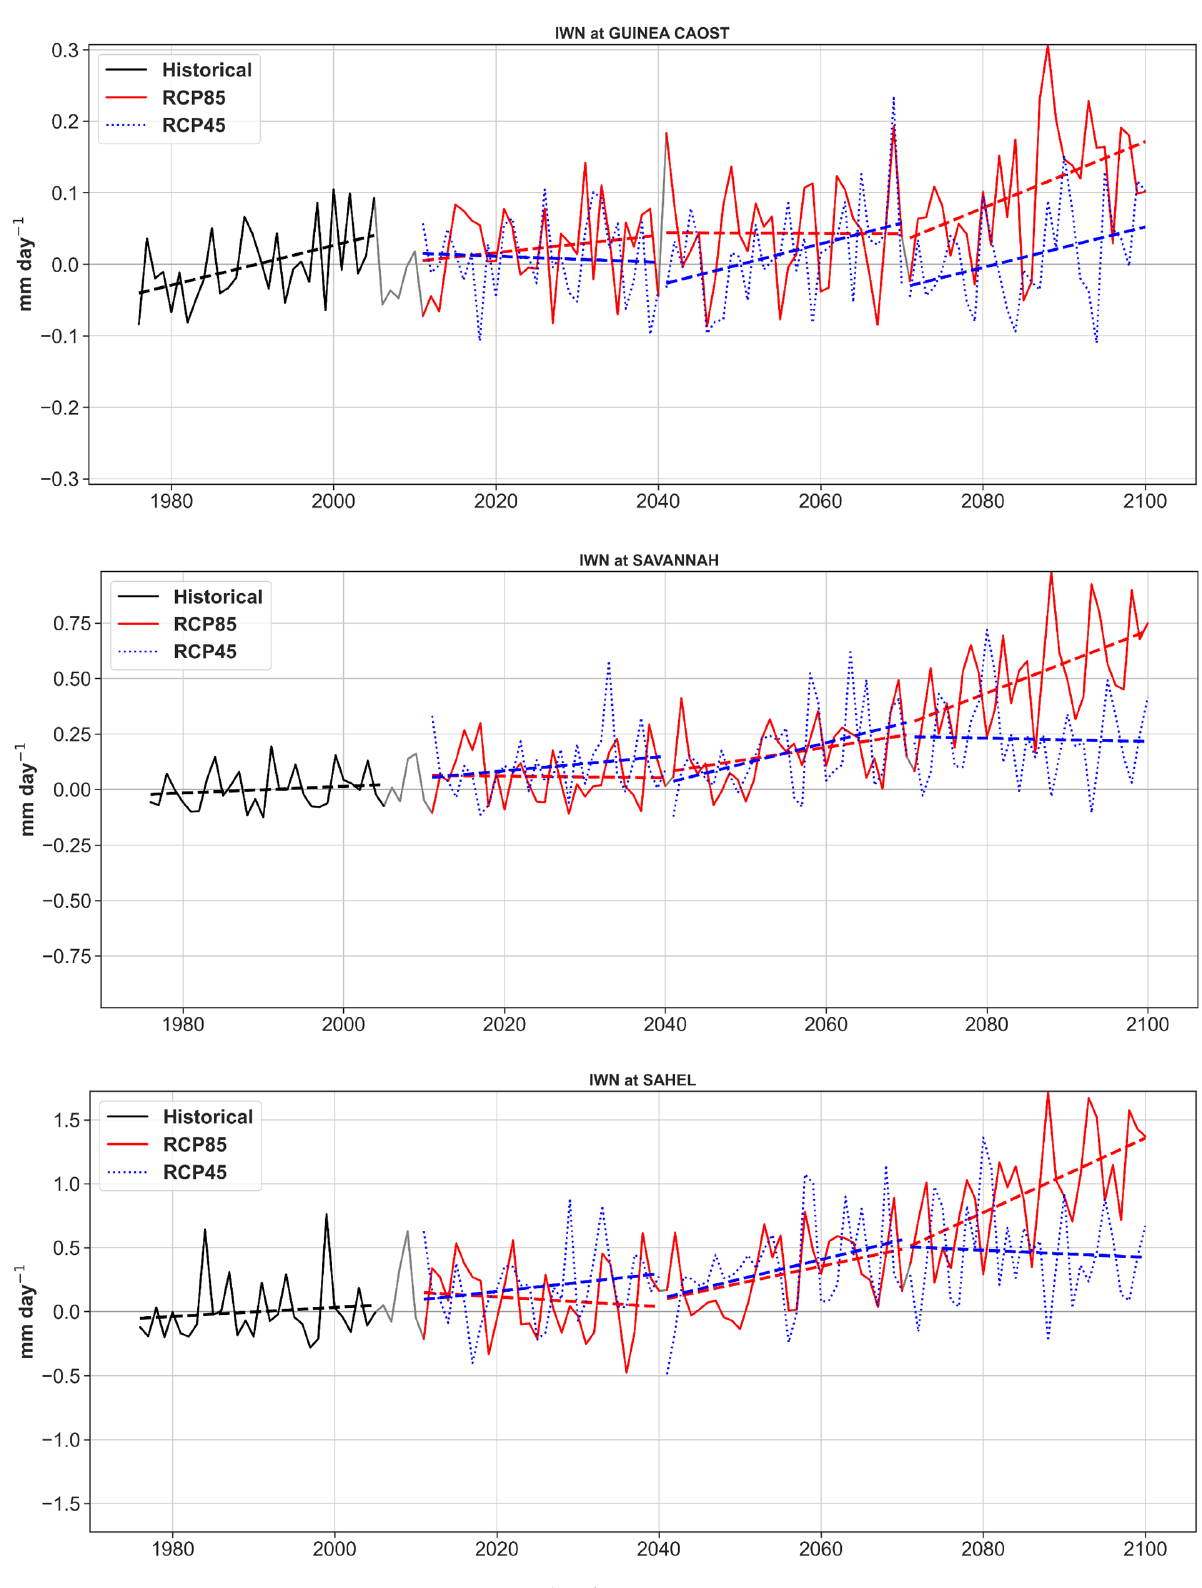
Figure 9. Same as Figure 8, but for IR.